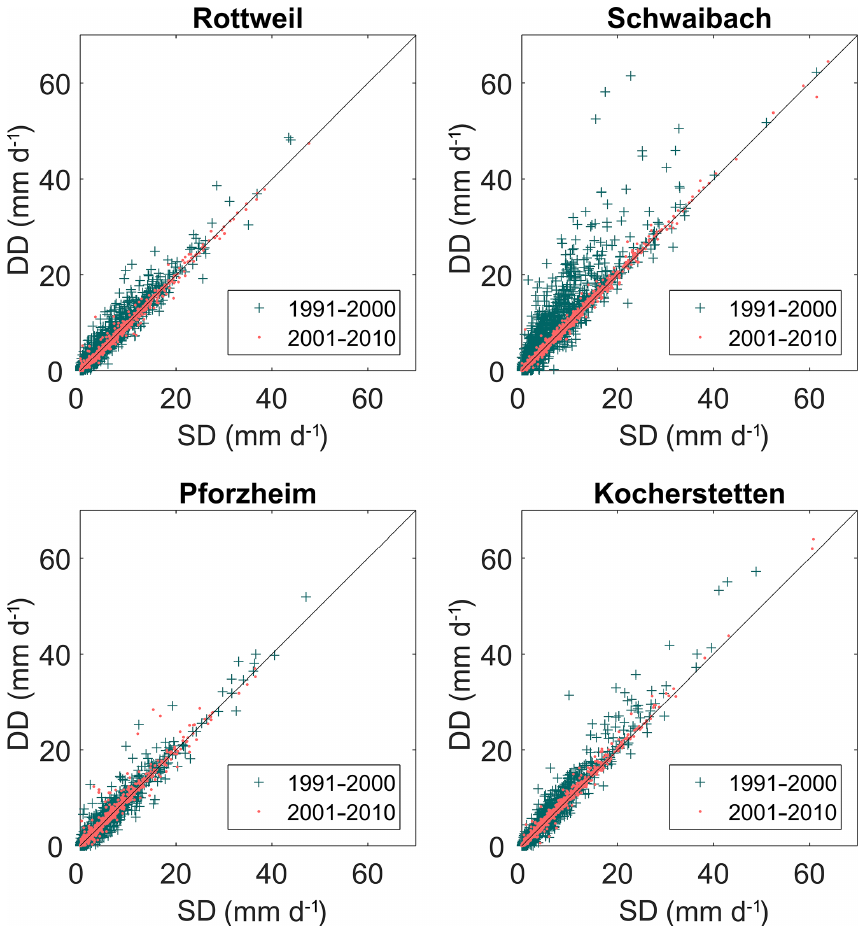
Figure 5. Comparison of the daily rainfall data that were interpolated using different densities of raingauge